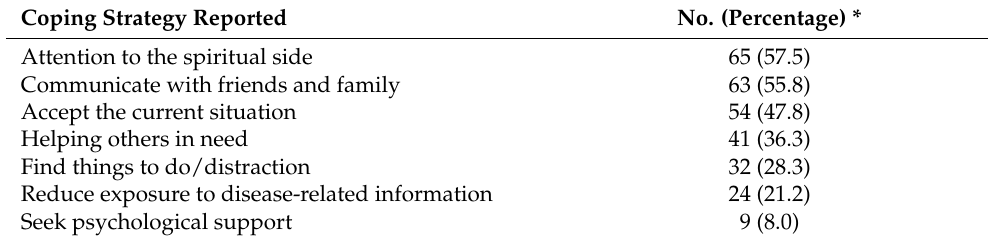
Table 4. Coping Strategies as Reported by Studied Nurses to Deal with Work-related Stress. ( n = 113). Coping Strategy Reported No. (Percentage) * Attention to the spiritual side 65 (57.5) Communicate with friends and family 63 (55.8) Accept the current situation 54 (47.8) Helping others in need 41 (36.3) Find things to do/distraction 32 (28.3) Reduce exposure to disease-related information 24 (21.2) Seek psychological support 9